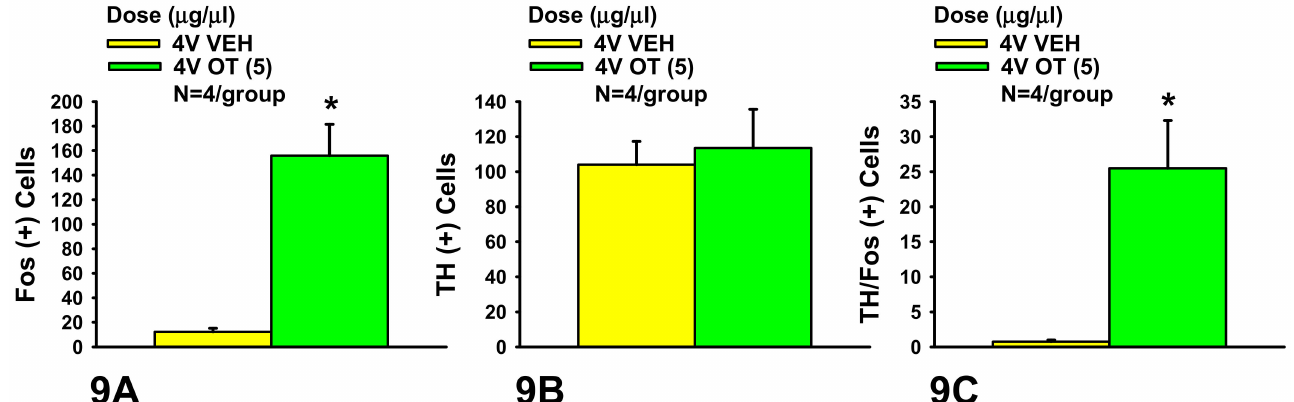
Figure 9. ( A – C ). Effect of acute 4V OT administration on Fos induction in cNTS catecholamine neurons in male chow-fed SD-SAS rats. A, Acute 4V administration of OT increased the number of Fos (+) cells in the cNTS but had no impact on B, the number of TH (+) cells. C, Acute 4V OT treatment increased the number of cNTS neurons that expressed both TH and Fos (N = 4/group). Data are expressed as mean ± SEM. * P < 0.05 OT vs.